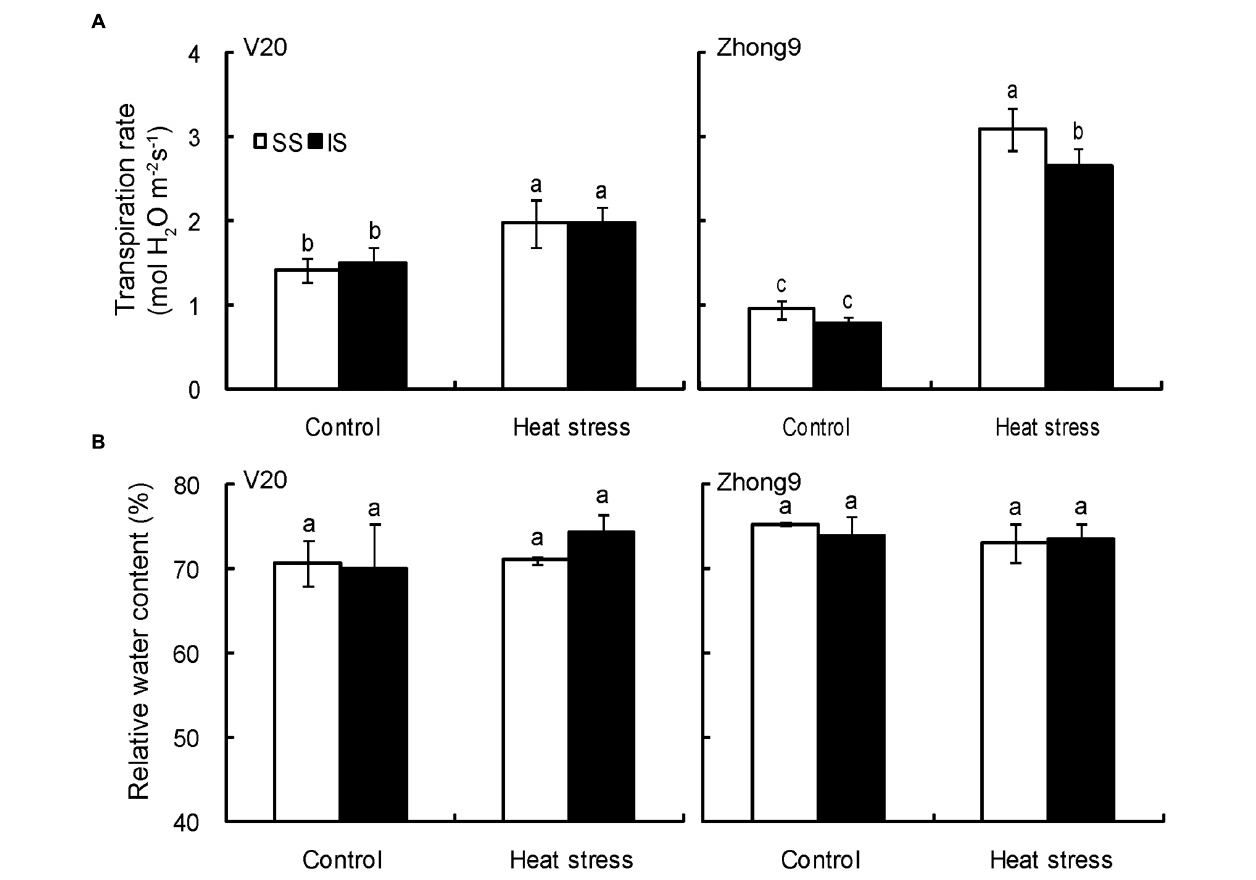
FIGURE 7 | Effect of heat stress on the transpiration rate (A) and relative water content (B) of superior and inferior spikelets at anthesis of rice. SS and IS were indicated as superior spikelets and inferior spikelets, respectively. The data in the figures (A,B) were showed as the mean of 10 replicates. Vertical bars denote standard deviations ( n = 3). Different letters indicate significant differences between the superior spikelets and inferior spikelets in the same cultivar ( P <